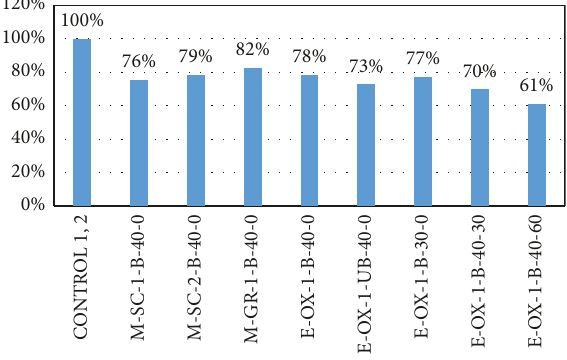
Figure 25: Ductility of developed prestressed